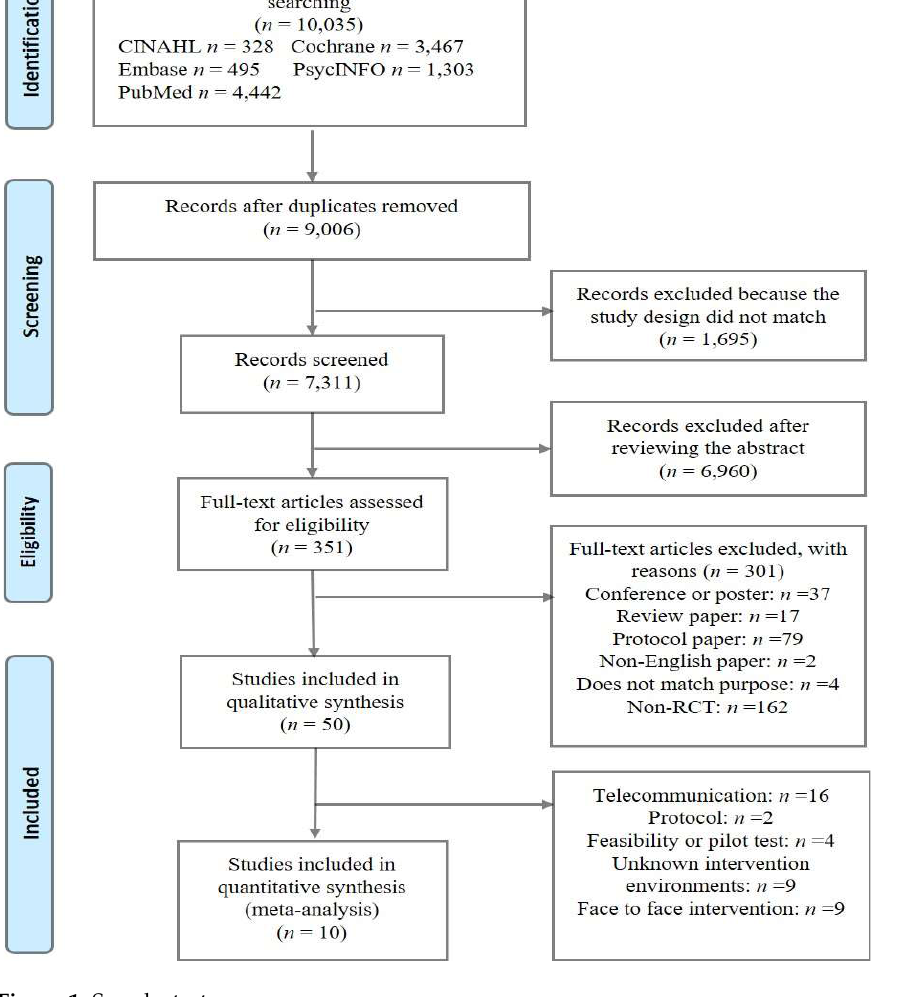
Figure 1. Search strategy.